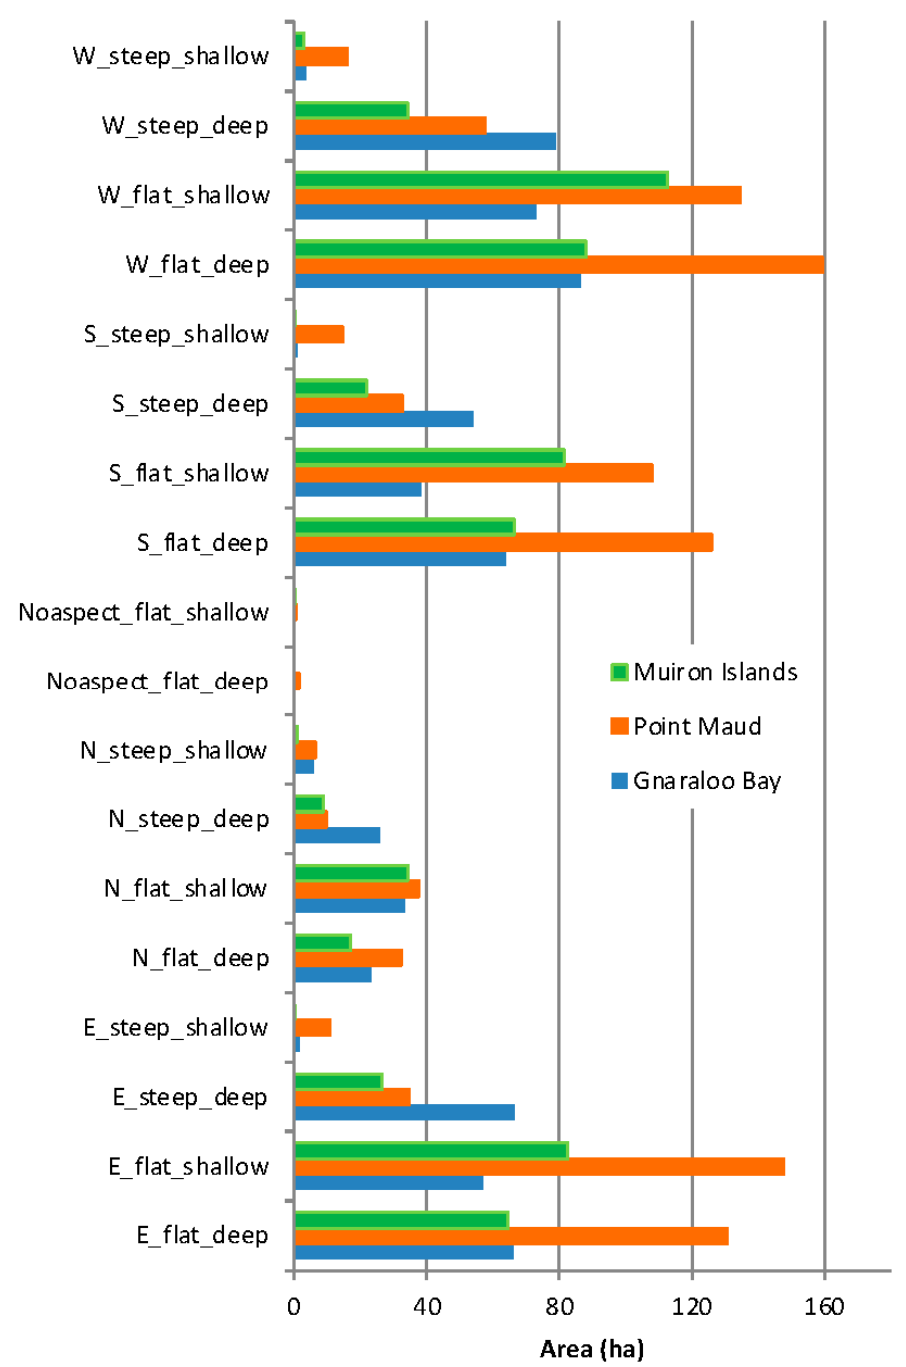
Figure 5. Area (hectares) of all possible topographic classes in the three focus areas along the Ningaloo Reef.